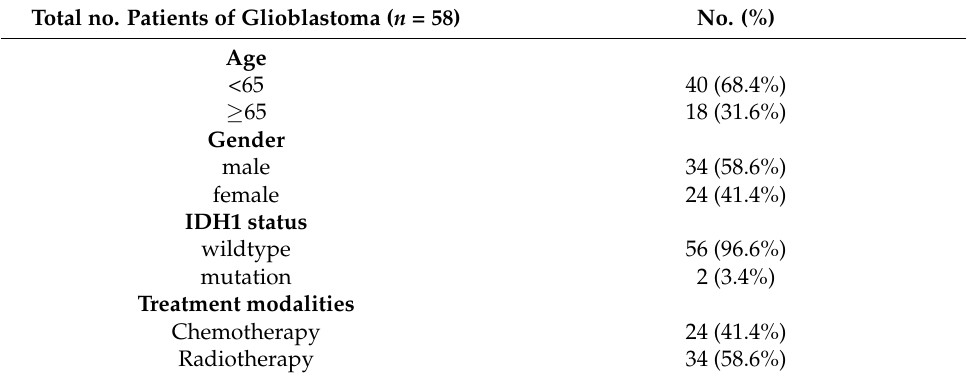
Table 2. Patients’ clinicopathological